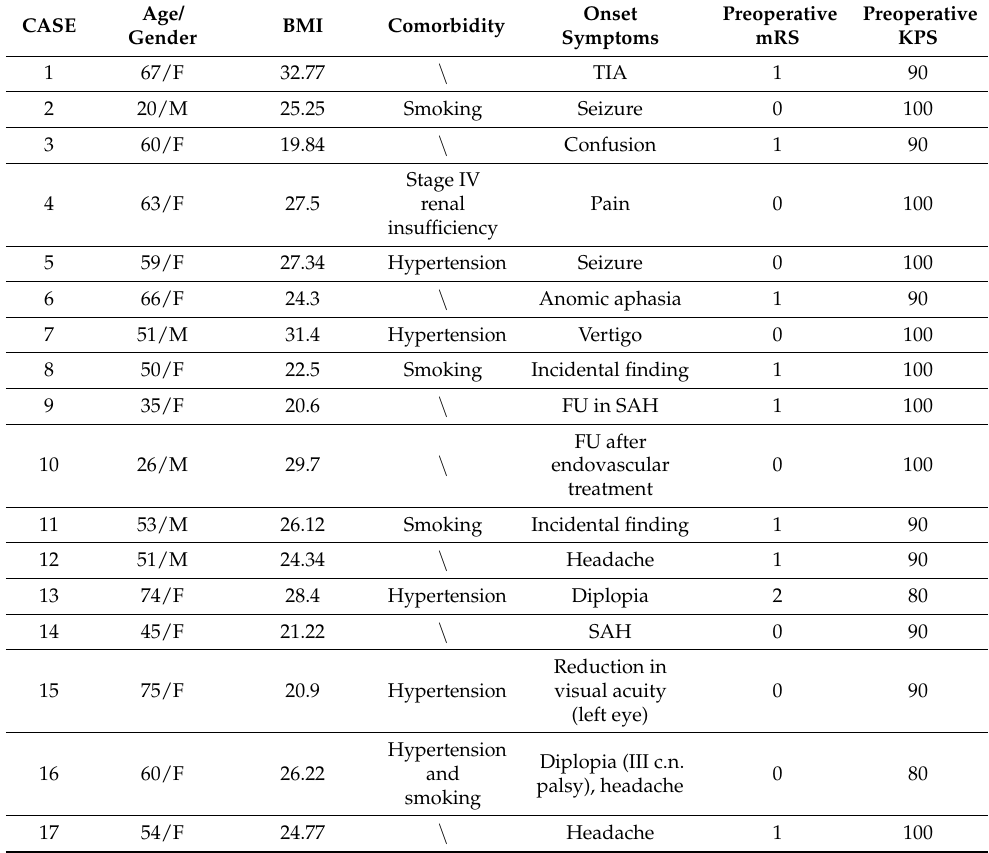
Table 2. Summary of preoperative patients’